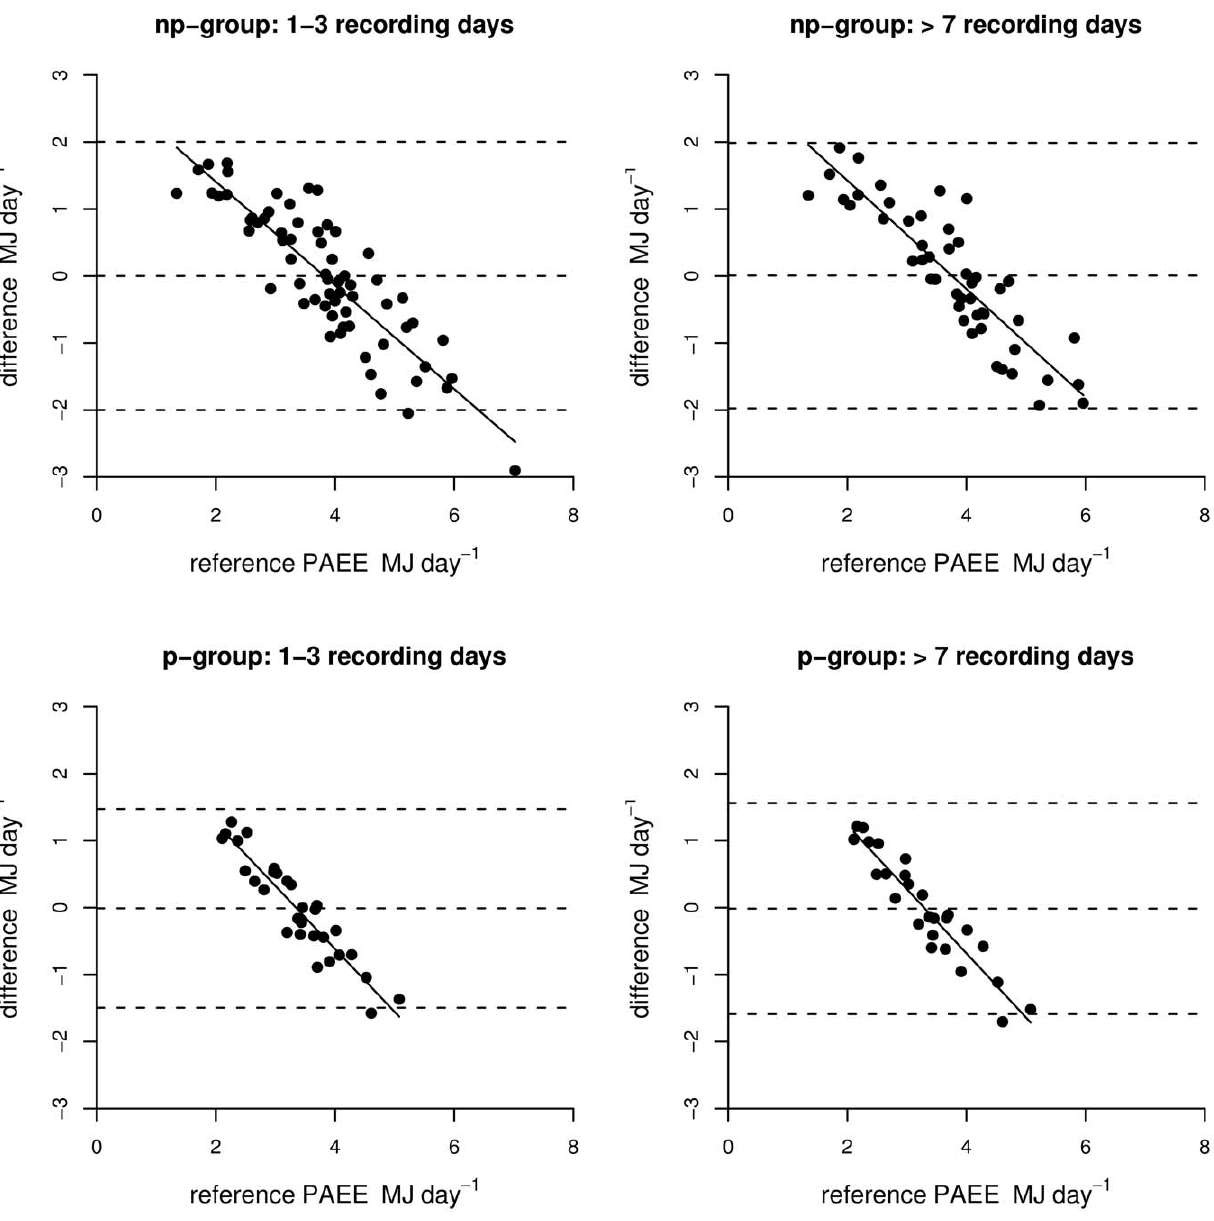
Figure 3. Error of estimated physical activity-related energy expenditure (PAEE) in MJ day 2 1 based on acceleration (Acc 2 ) as a function of reference PAEE for p-group (pregnant) and np-group (non-pregnant). Dashed lines represent the average difference and 95% confidence intervals ( 2 2.00–2.00 np-group 1–3 days; 2 1.97–1.99 np-group . 7days; 2 1.50–1.47 p-group 1–3 days; 2 1.59–1.56 p-group . 7 days).